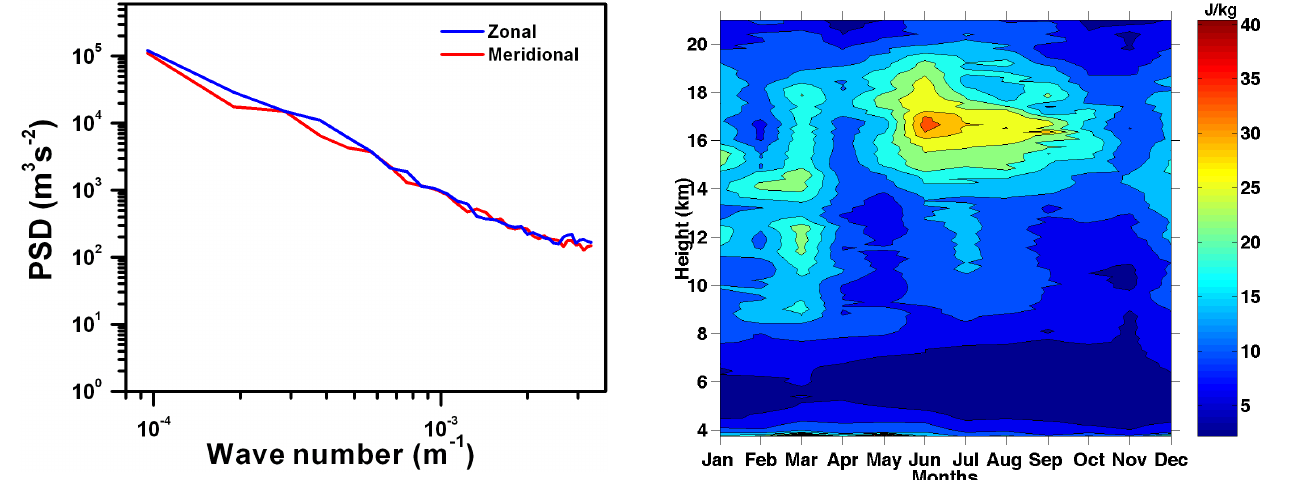
Fig. 5. Height-month section of total kinetic energy estimated using ten-years of